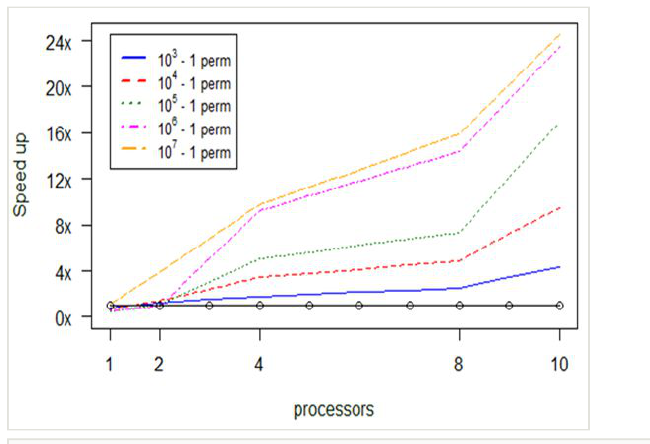
Computational results about optimization in anosim's performance, depending on permuations and number of processors (np), for small datasets.